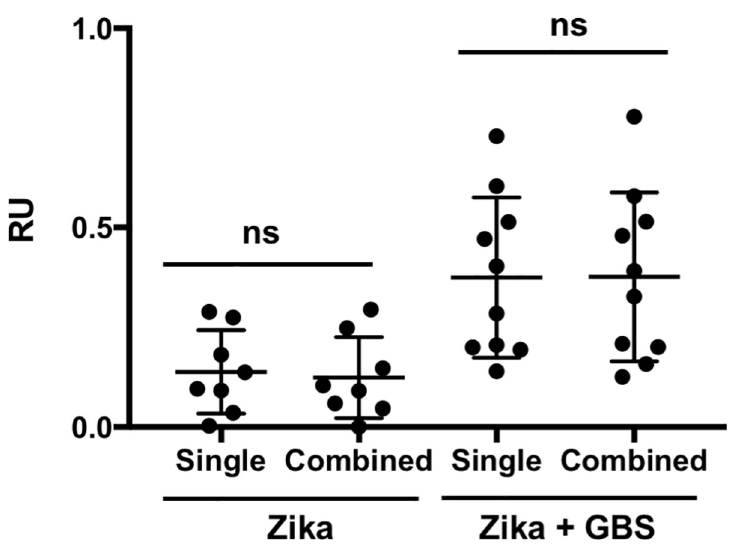
Fig 2. Reactivity to single glycolipids versus combinations. Average antibody reactivity of samples from patients with Zika or Zika + GBS was analyzed for single and combined glycolipids. Each dot represents the average reactivity to all single or combined glycolipids for each plasma sample. No significant (ns) differences between single and combined groups were found when compared by unpaired